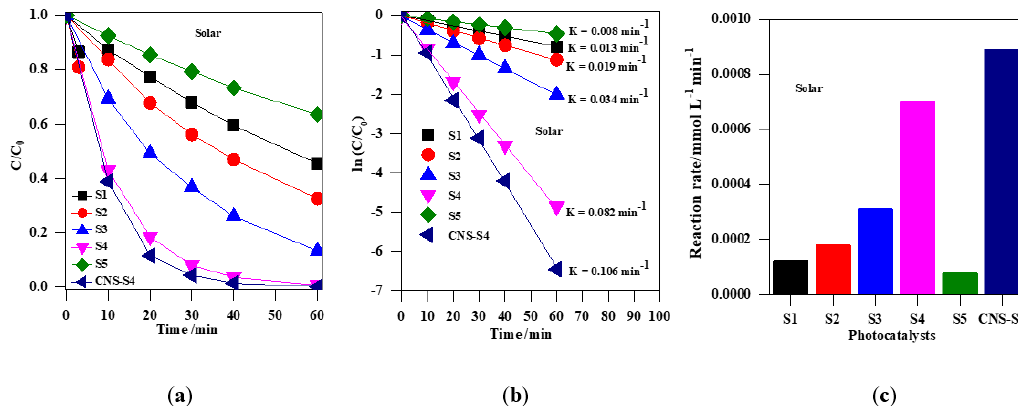
Figure 7. ( a ) change of the MC-LR concentration during irradiation; ( b ) plot of ln (C/C 0 ) versus irradiation time; ( c ) comparison of the degradation rate of MC-LR using S1, S2, S3, S4, S5, and CNS- S4 photocatalysts under UV-A light. Catalyst loading, 0.4 g L − 1 ; MC-LR dose, 10 mg L − 1 ; pH, 4; T, 25 °C; reaction volume 40 mL.